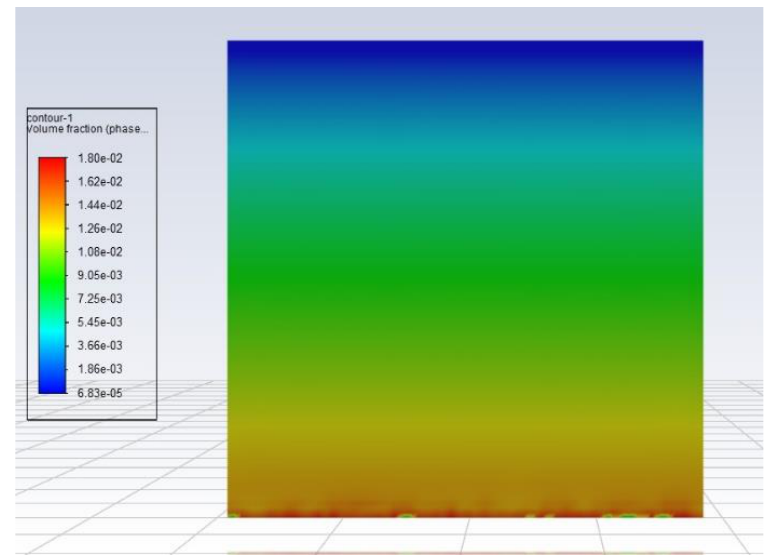
Figure 7. Liquid film distribution of filmwise condensation.